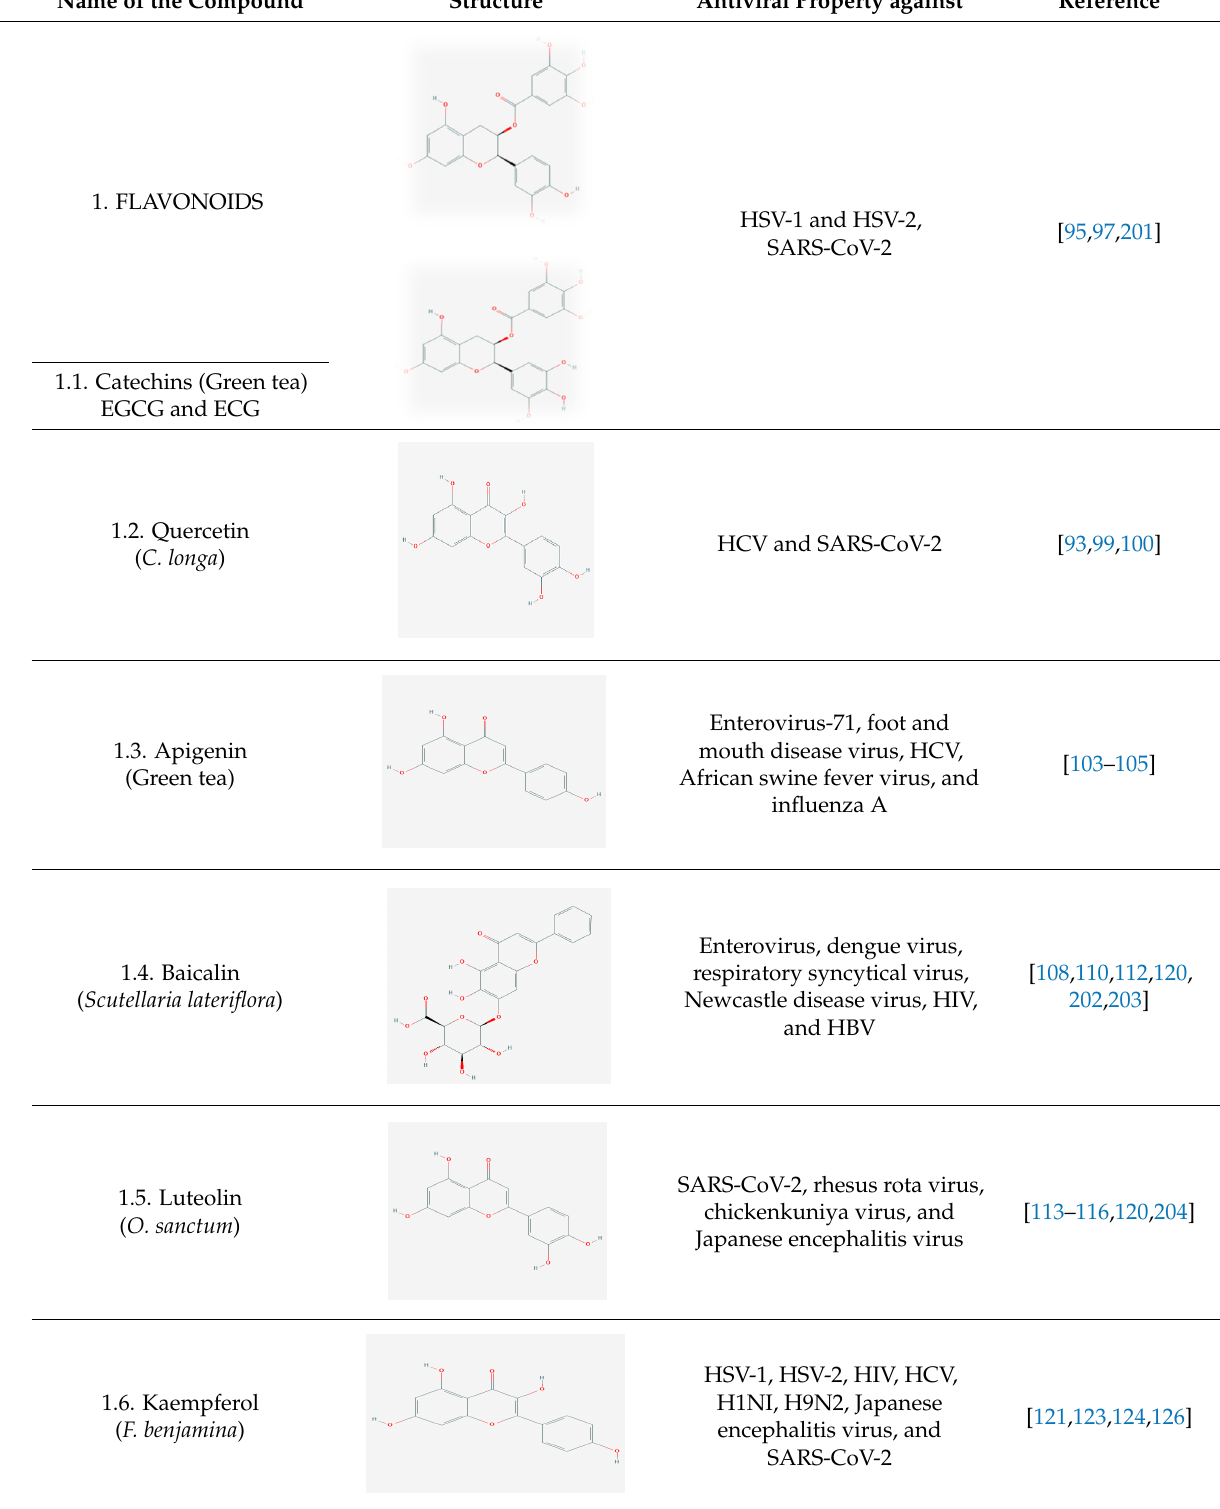
Table 2. Plant compounds and their antiviral properties.